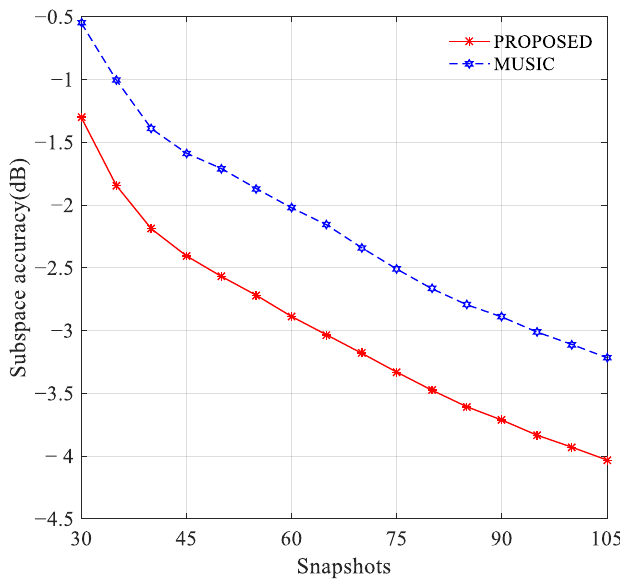
Figure 2. Accuracy of signal subspace versus the number of snapshots.